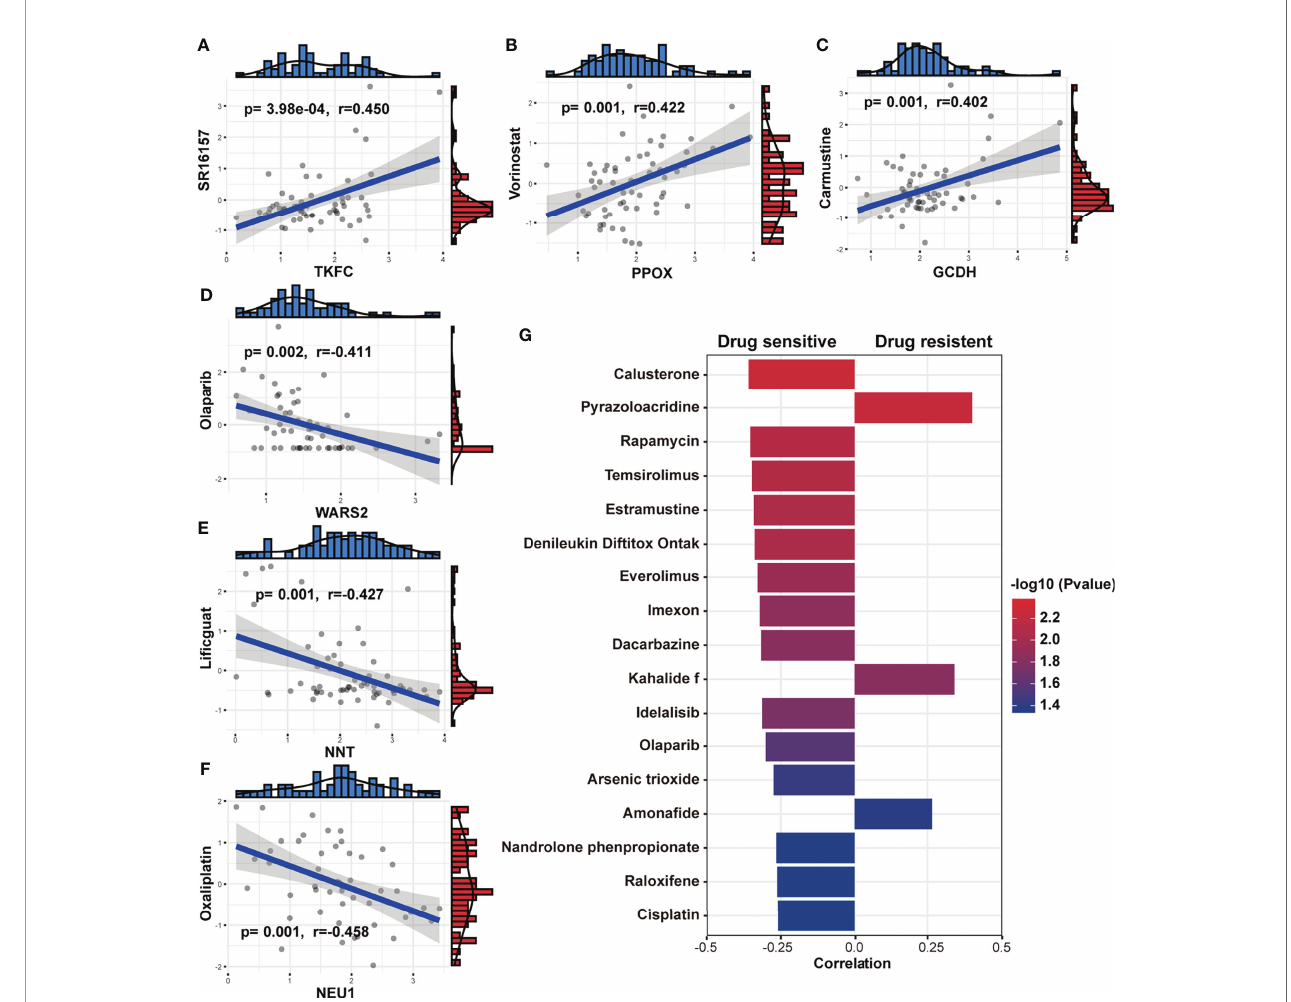
FIGURE 8 | Association between MRGs, Metabolism Score and clinic drug vulnerability. (A-F) Gene expression and drug IC50 were downloaded from CellMiner and used to evaluate the correlation coef fi cient between MRGs and drug vulnerability. (G) The correlation coef fi cient was calculated based on the Metabolism Score and drug IC50. Higher coef fi cients were shown with longer bars, and the color of bars was counted by